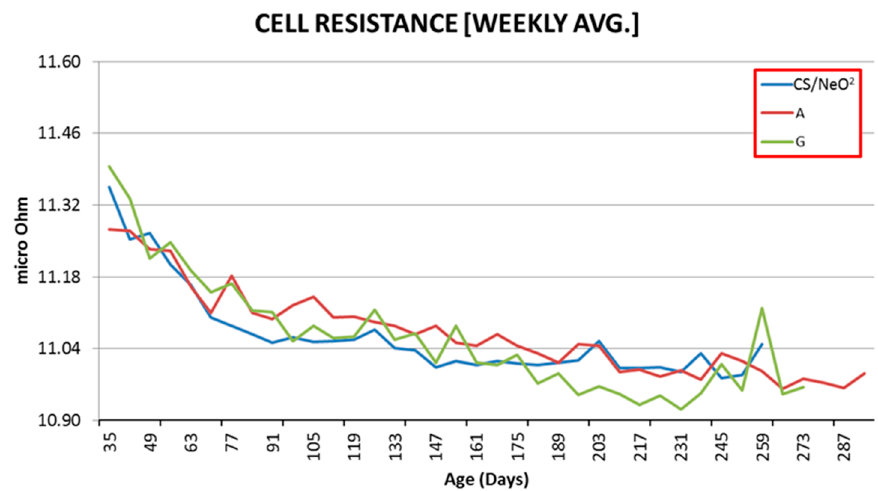
Figure 8. Cell resistance weekly average values ((in micro Ohm)) for pots with different pastes.